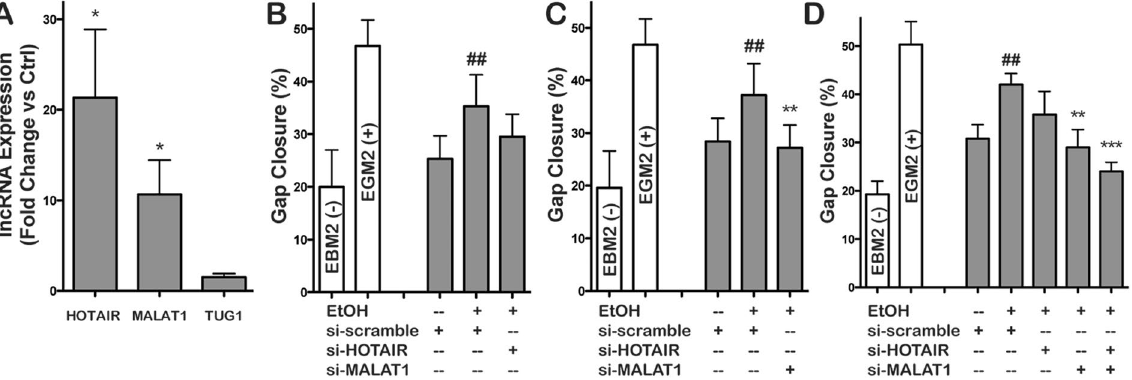
Figure 6. Ethanol regulates endothelial cell-derived EV lncRNA content. ( A ) Expression levels of the indicated lncRNAs were assessed by qPCR in EVs from HUVECs cultured in the presence vs. absence of 100 mM EtOH for 24 h (n = 3; * P < 0.05). ( B – D ) HUVEC gap closure was assessed following 24 h stimulation by 100 µ g/ml EVs from HUVECs cultured in the absence ( − EtOH) or presence ( + EtOH) of 100 mM EtOH for 24 h following transfection with a scrambled siRNA (scr) or siRNA specific to (B) HOTAIR, ( C ) MALAT1, or ( D ) both HOTAIR and MALAT1 (double transfection) (n = 4; ## P < 0.01 vs. – EtOH + scr; ** P < 0.01, *** P < 0.001 vs. + EtOH + scr). HUVECs incubated in basal medium (EBM2, without growth factors) were used as the negative control ( − ) and HUVECs incubated in growth medium (EGM2, with growth factors) were used as positive controls ( +